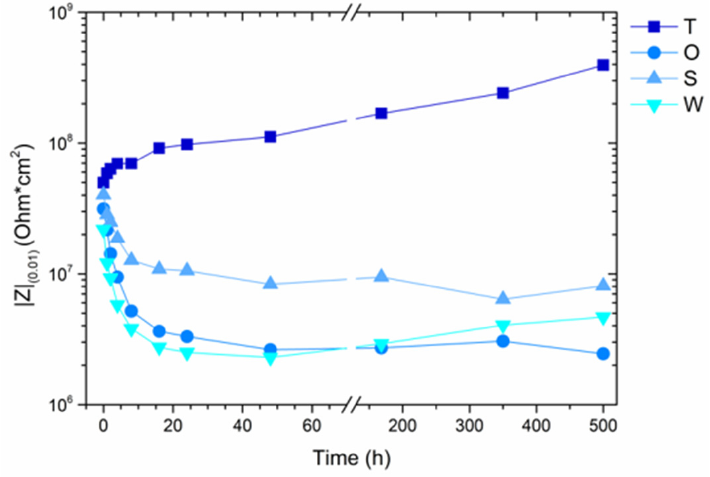
Figure 14. Bode impedance modulus |Z| (0.01) evolution with